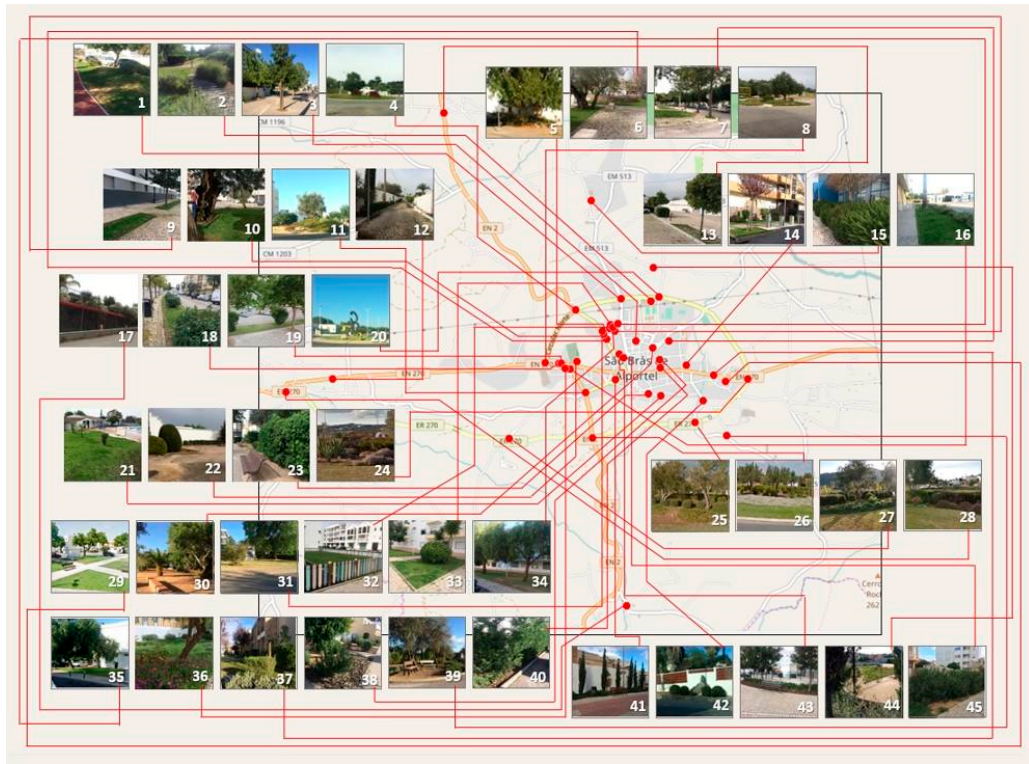
Figure 2. Localization of the 45 urban green areas in São Brás de Alportel.